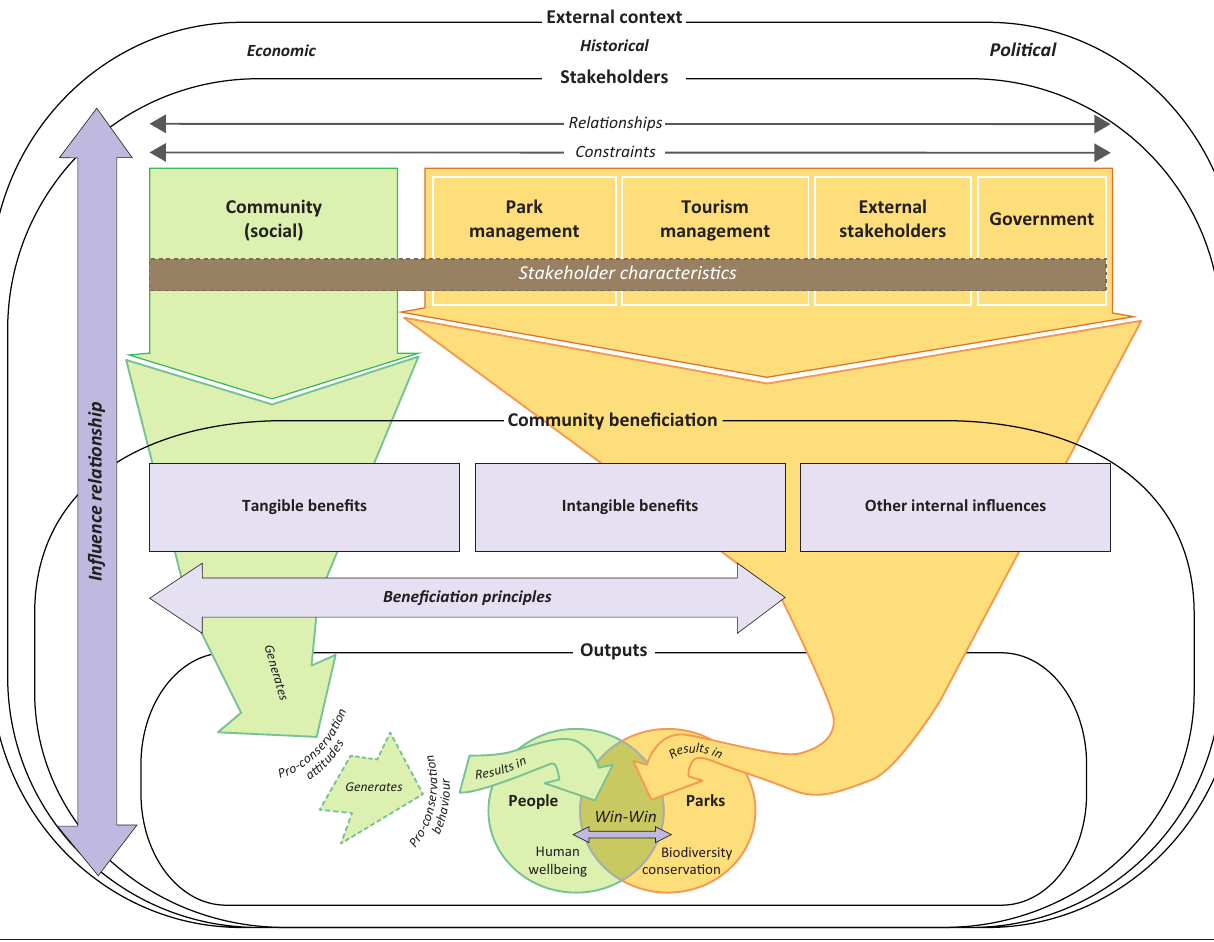
FIGURE 3: Simplified People Parks Win-Win Framework.